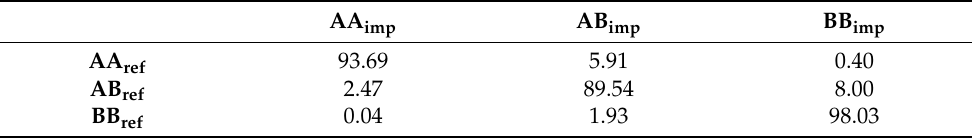
Table 6. Concordance rate in percentage between imputed and real genotypes with a reference panel of 190 purebred